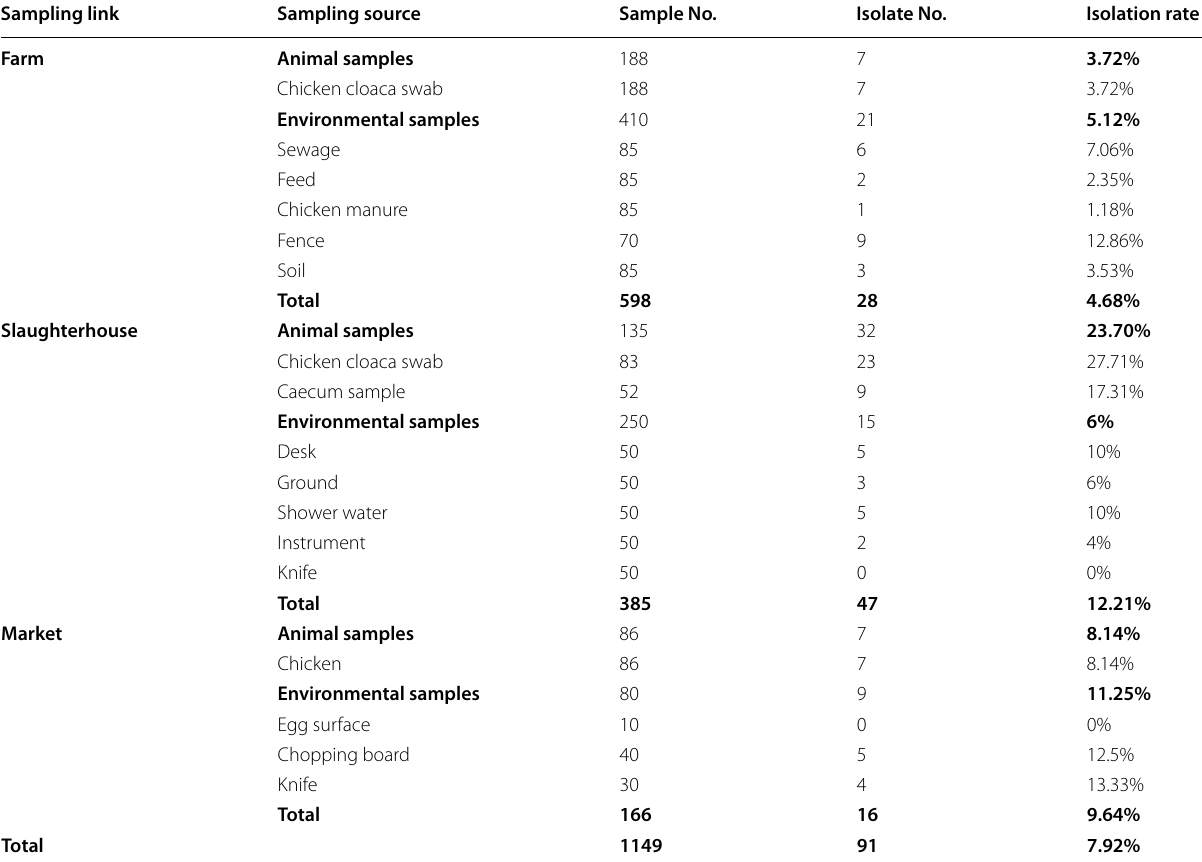
Table 1 Isolation of Salmonella from different sample sources in the chicken production chain in Hubei Province, China Sampling